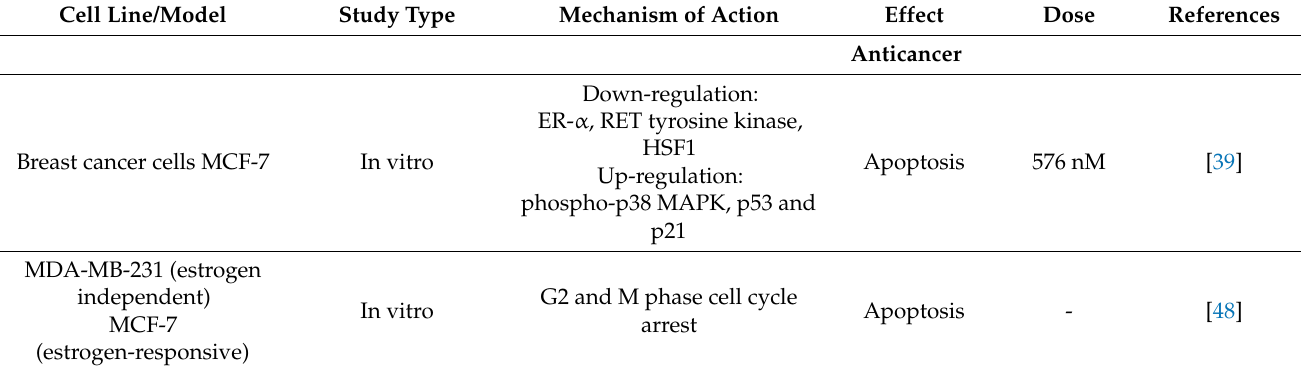
Table 2. Summary of studies on effect of withaferin A on different cell lines. Cell